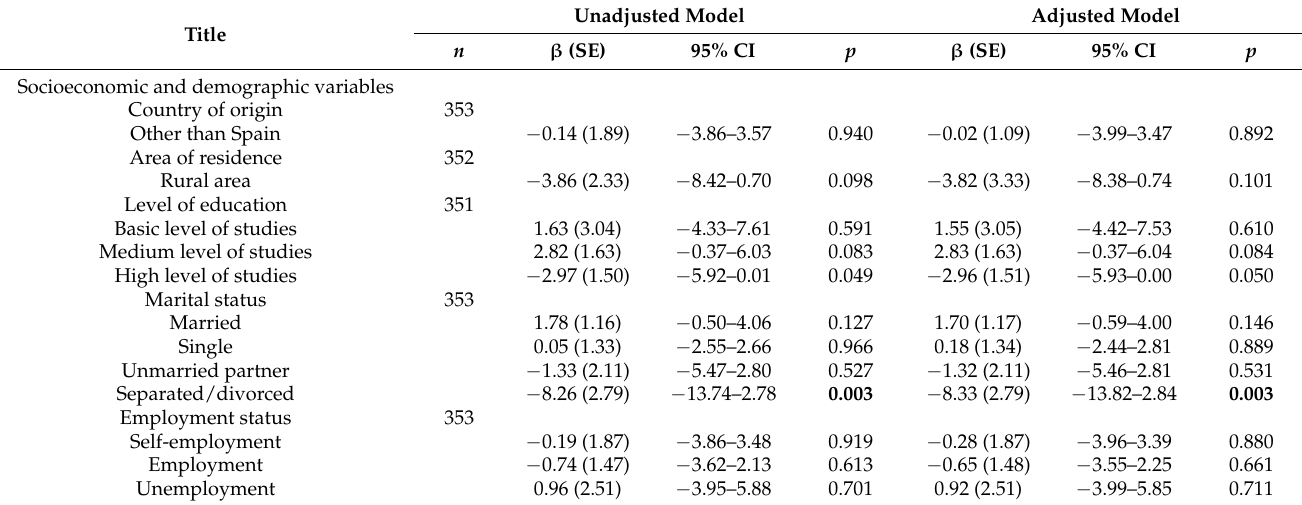
Table 2. Multilevel linear regression models for STAI-S score ( n =